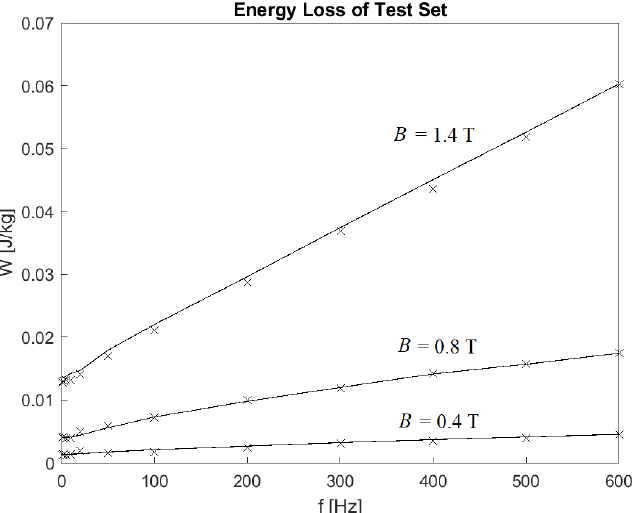
Figure 5. Comparison of the specific energy-loss curves obtained via the integration of the simulated loops (cross-shaped markers) with the measured ones (continuous black line) for the amplitudes of B not involved in the training.